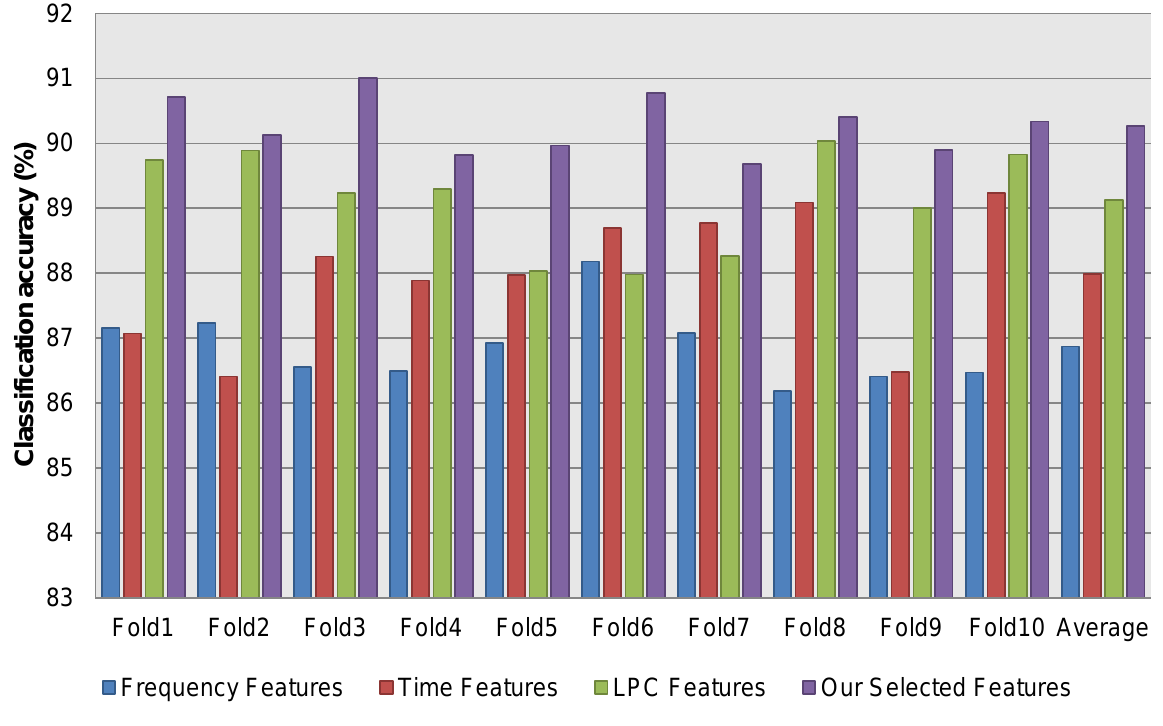
Figure 4. Accelerometer classification accuracy comparison based on Table